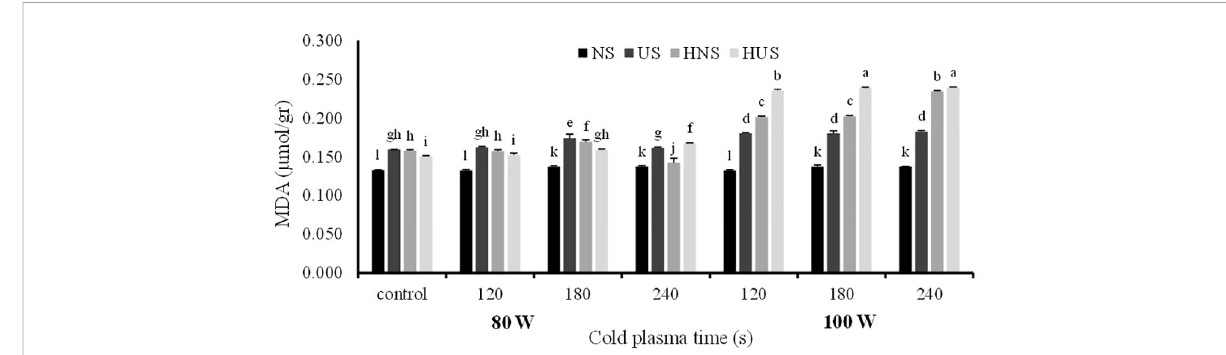
FIGURE 8 The effect of power and exposure time of cold plasma and seed situation on MDA content of S. leriifolia germinated seeds. Normal seeds (NS), Uncovered seeds (US), Hydro-primed normal seeds (HNS) and Hydro-primed uncovered seeds (HUS). Values represent mean ± S.E. Different letters indicate signi fi cant differences at the 1% level according to the LSD